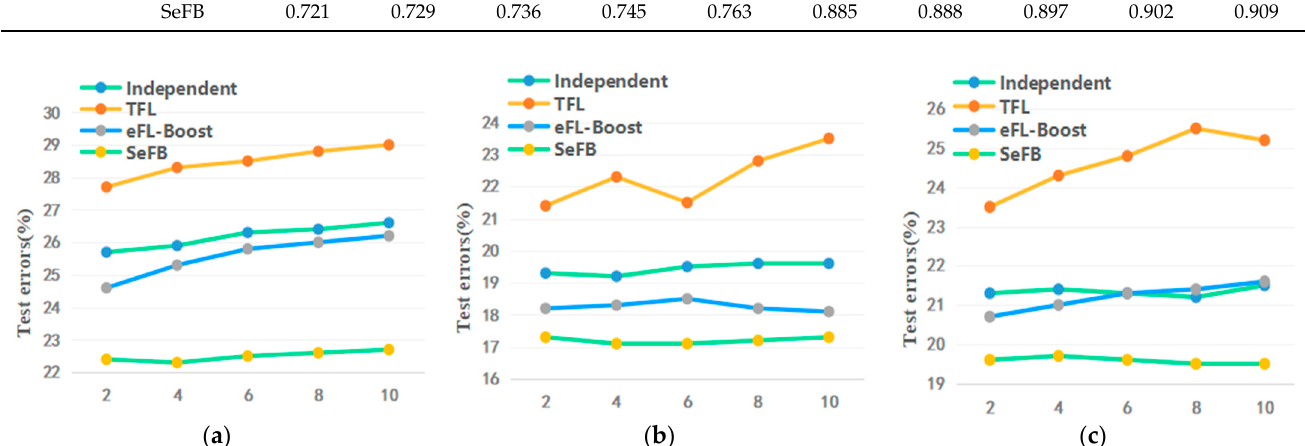
Figure 4. Impact of number of participants on Test Errors. ( a ) Credit 1 dataset, ( b ) Credit 2 dataset, ( c ) Adult dataset.